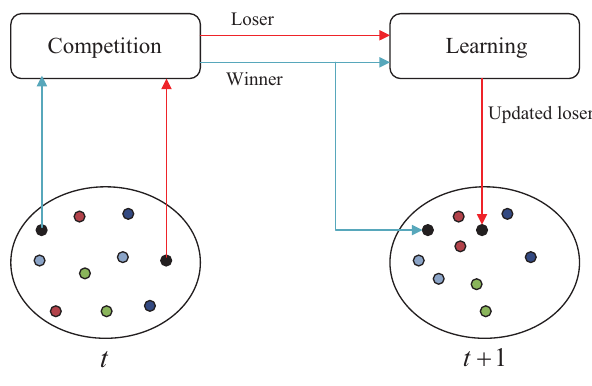
Figure 4. Search mechanism of the Competitive Swarm Optimizer (CSO) algorithm.